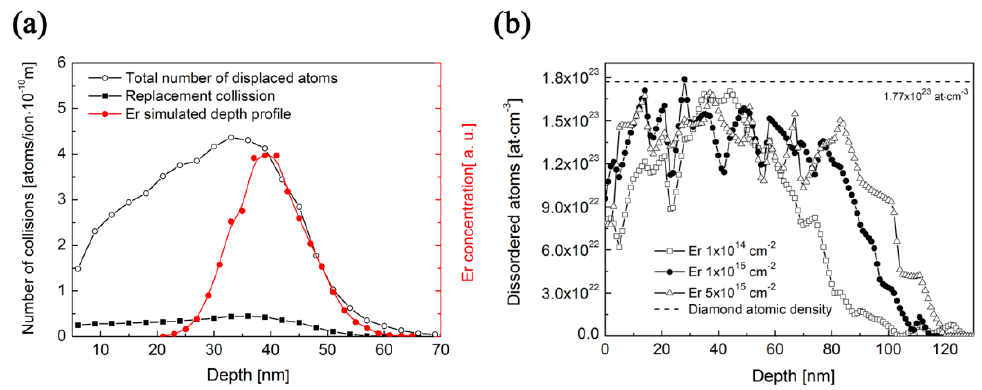
Figure 2. ( a ) Stopping and Range of Ions in Matter (SRIM)-simulated Er concentration depth profile in a pure diamond structure with a density of 3.5 g·cm − 3 and the depth profile of displaced atoms produced in a diamond structure as simulated by SRIM; ( b ) Theoretically determined atomic density depth profile of displaced atoms for different implantation fluences using experimentally-determined channelling spectra of erbium in single-crystalline diamond with the same energy [29].